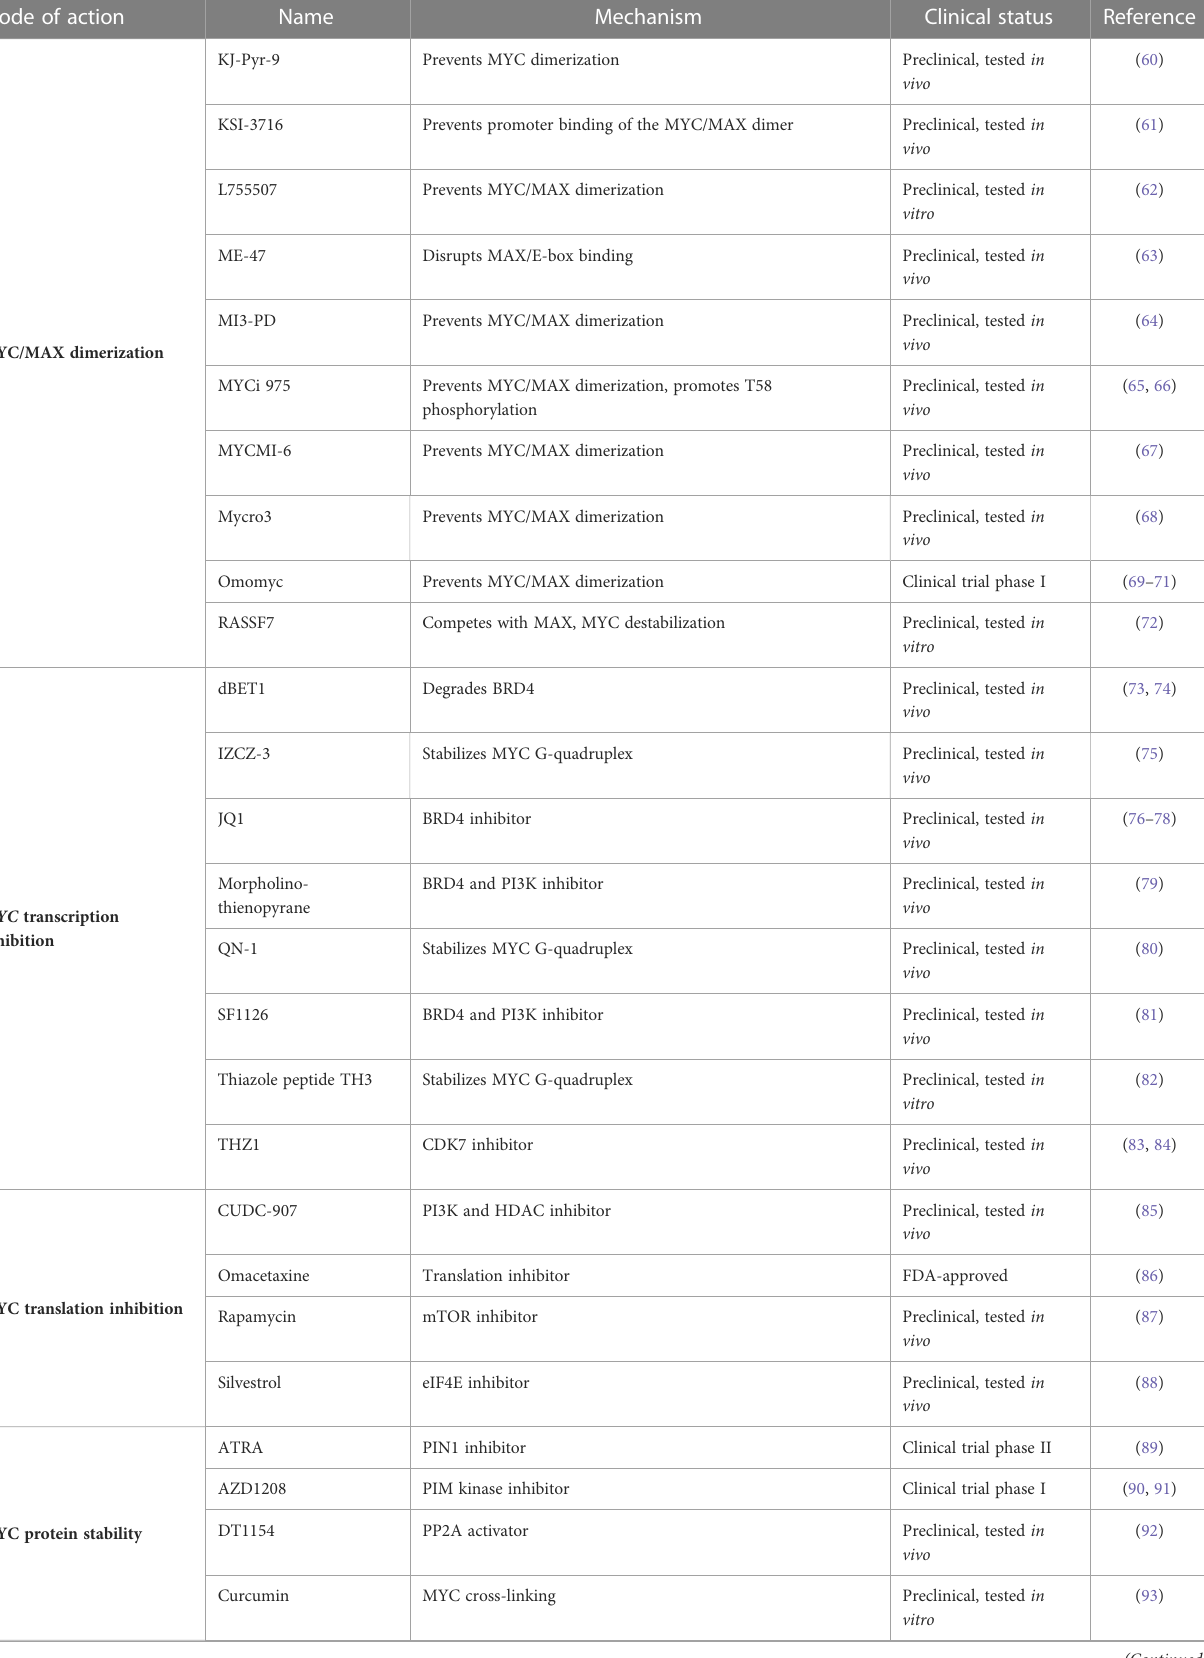
TABLE 1 Molecules interfering with oncogenic MYC